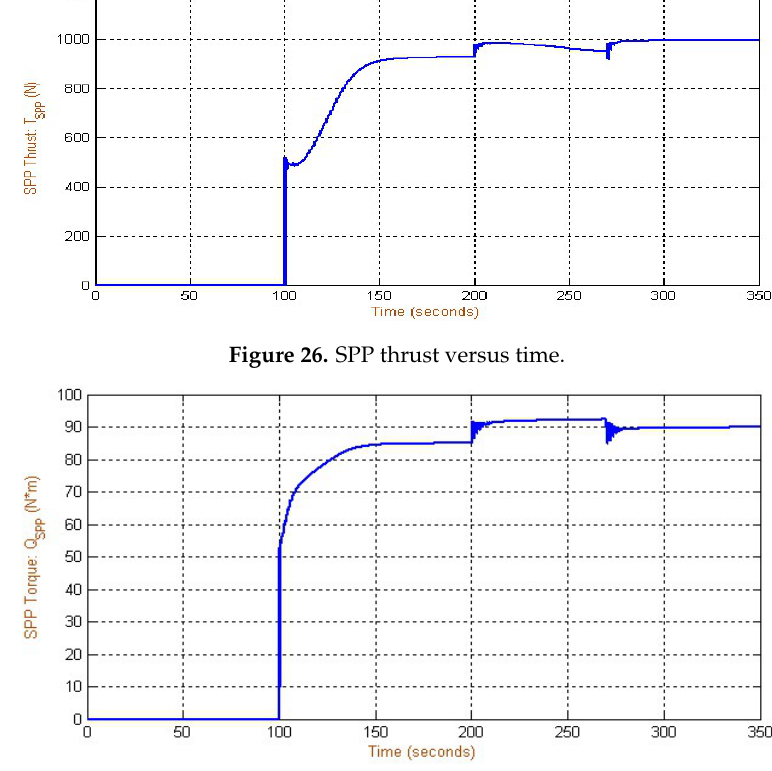
Figure 27. SPP torque versus time.